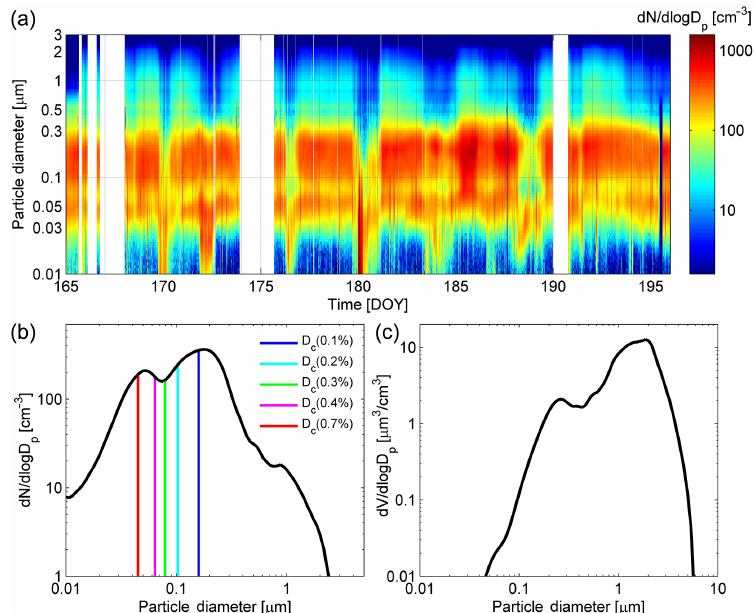
Figure 2. Size distributions corrected neither for particle losses in the tubing nor for detection efficiency. MPSS data cover the mobility diameter range 0.01–0.8µm, and APS data cover the range for volume equivalent diameters above 0.8µm. (a) The measured aerosol particle number size distributions vs. time in days of year. The colour scale indicates d N/ dlog (D p ) in cm − 3 . (b, c) The median particle number size distribution and the inferred median particle volume size distribution assuming spherical particles. The inferred median critical mobility diameters ( D c ) are indicated with vertical lines for the different supersaturations together with the median particle number size distribution.